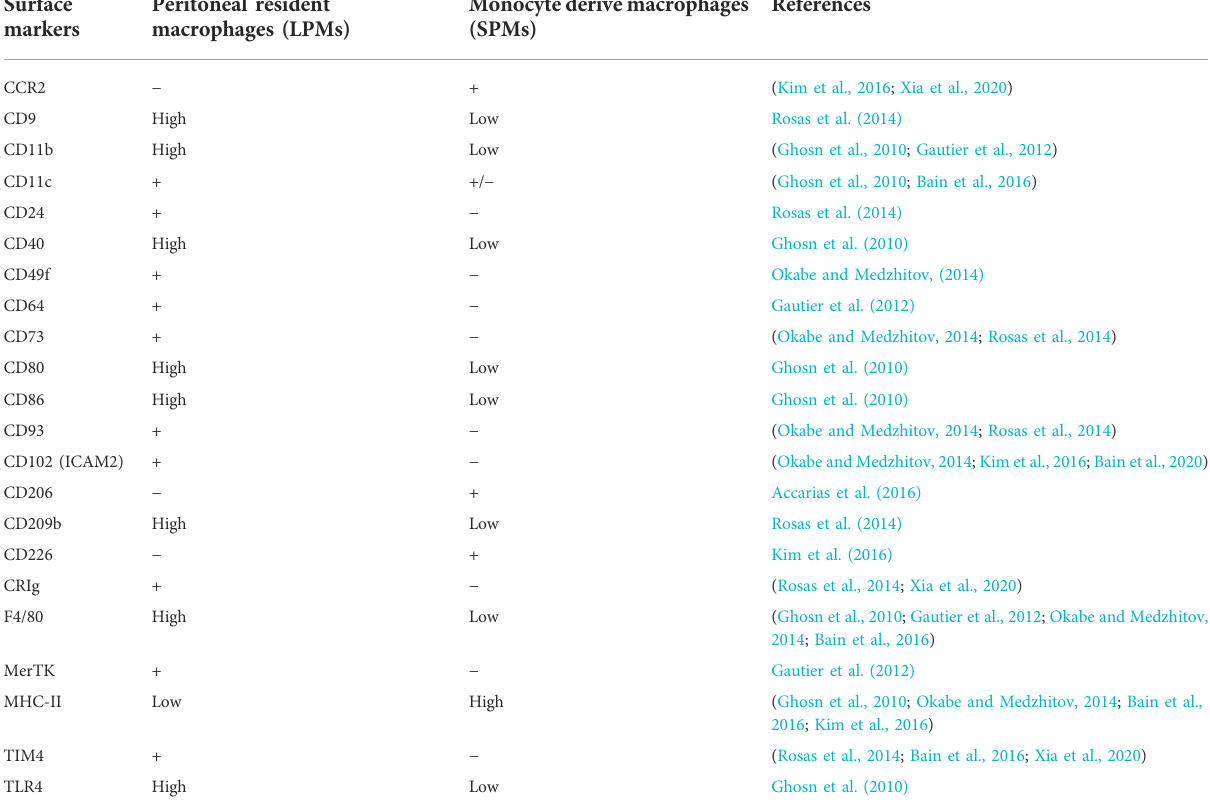
TABLE 1 The phenotypic difference between LPMs and SPMs in steady-state